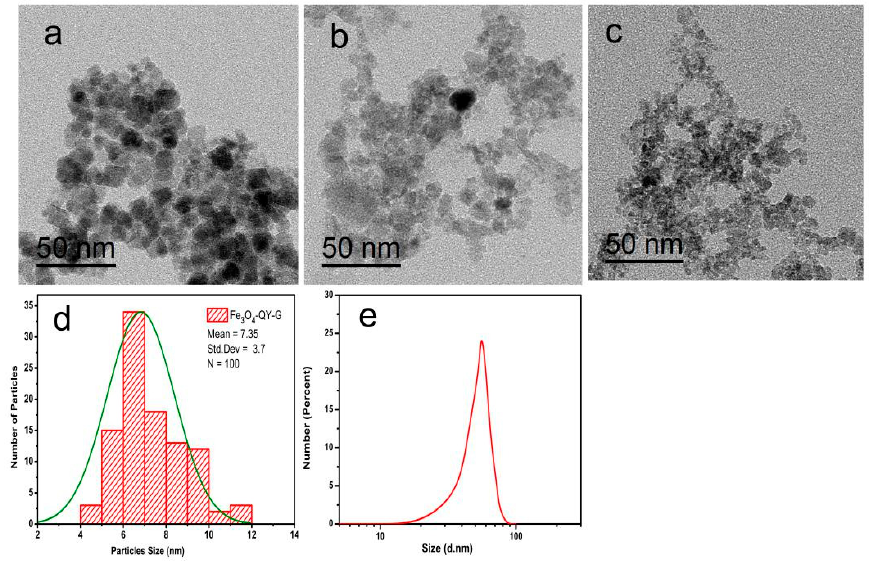
Figure 5. TEM images of nanoparticles: ( a ) Fe 3 O 4 , ( b ) Fe 3 O 4 -QY, ( c ) Fe 3 O 4 -QY-G, ( d ) corresponding size distribution of Fe 3 O 4 -QY-G nanoparticles, ( e ) hydrodynamic diameter of Fe 3 O 4 -QY-G nanoparticles.